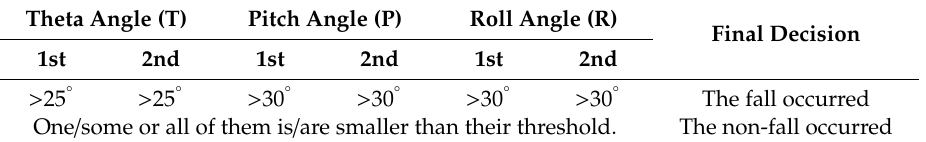
Figure 6. The proposed fall detection algorithm. Table 2. Final decision based on the combination of theta angle, pitch angle, and roll